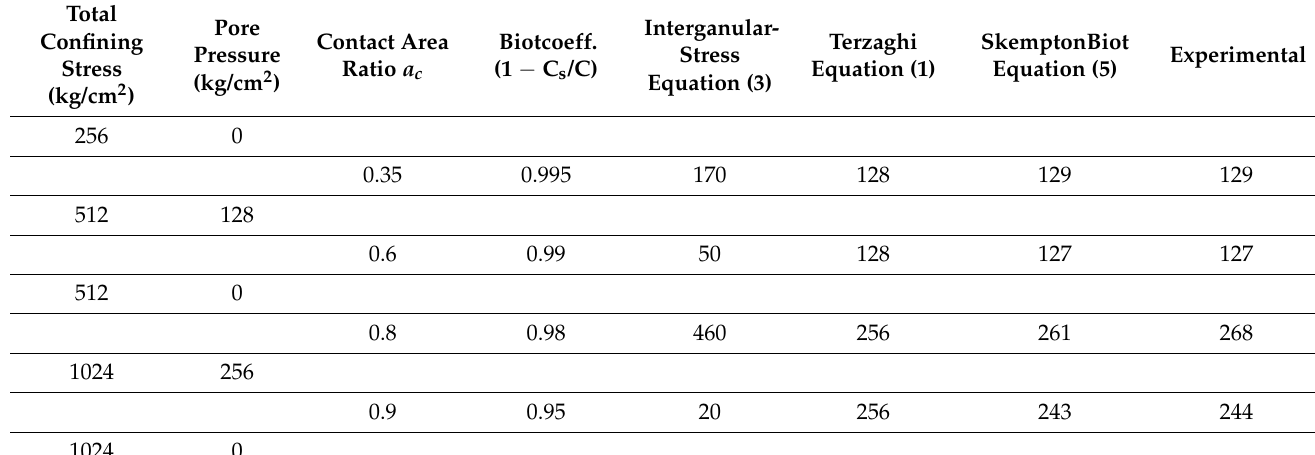
Table 1. Experimental data from oedometric test on lead shots. The test was carried out in steps; for each of them, an increment of total confining pressure was applied together with a known increment of pore pressure. Then, once the sample strain was measured, the pore pressure was reduced to zero. Modified from Skempton